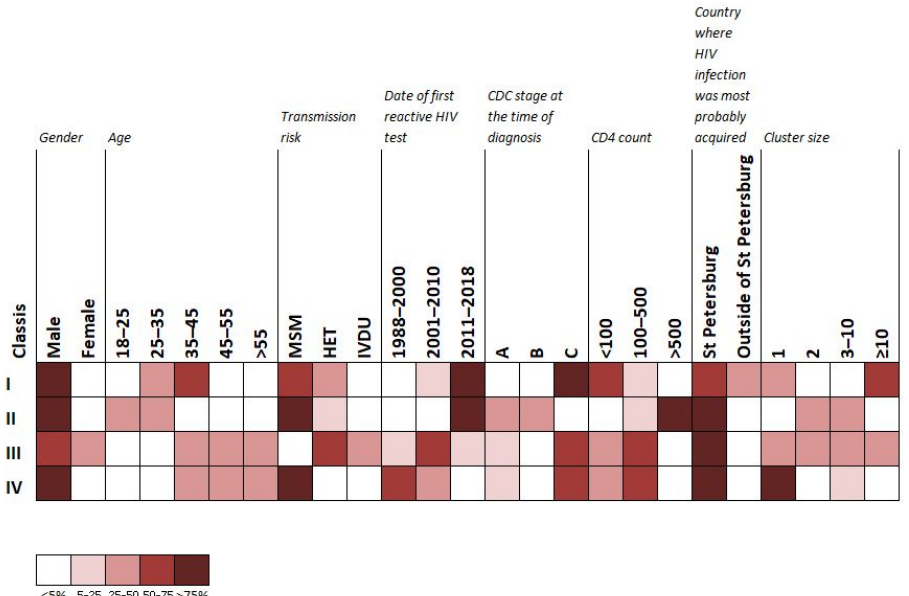
Figure 5. LCA result highlighted existence of four latent classes (indicated as I, II, III, IV), LCA was performed with poLCA software package in R, with study metadata and results of transmission clusters analysis as input. The distribution of participant characteristics within the latent class and predicted proportions in each cluster size by latent class are shown. Darker colors represent higher proportion as shown in the